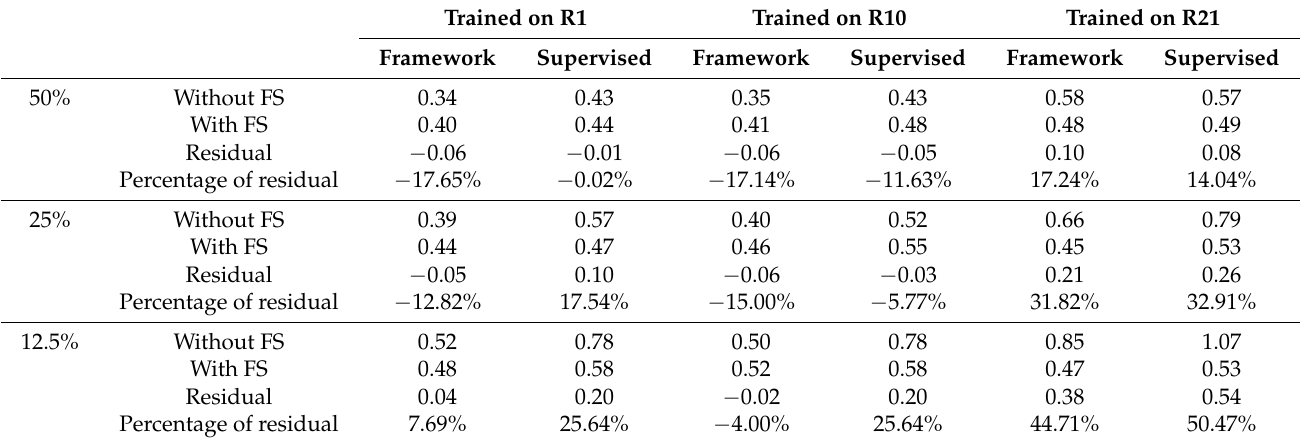
Table 5. Comparison of the mean MSE for networks with and without FS. Trained on R1 Trained on R10 Trained on R21 Framework Supervised Framework Supervised Framework